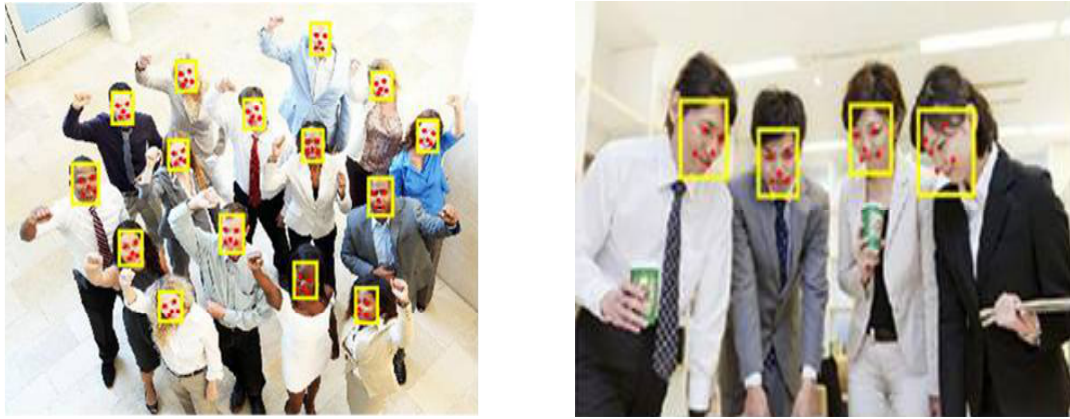
Figure 4. Sample experiment results using MTCNN.